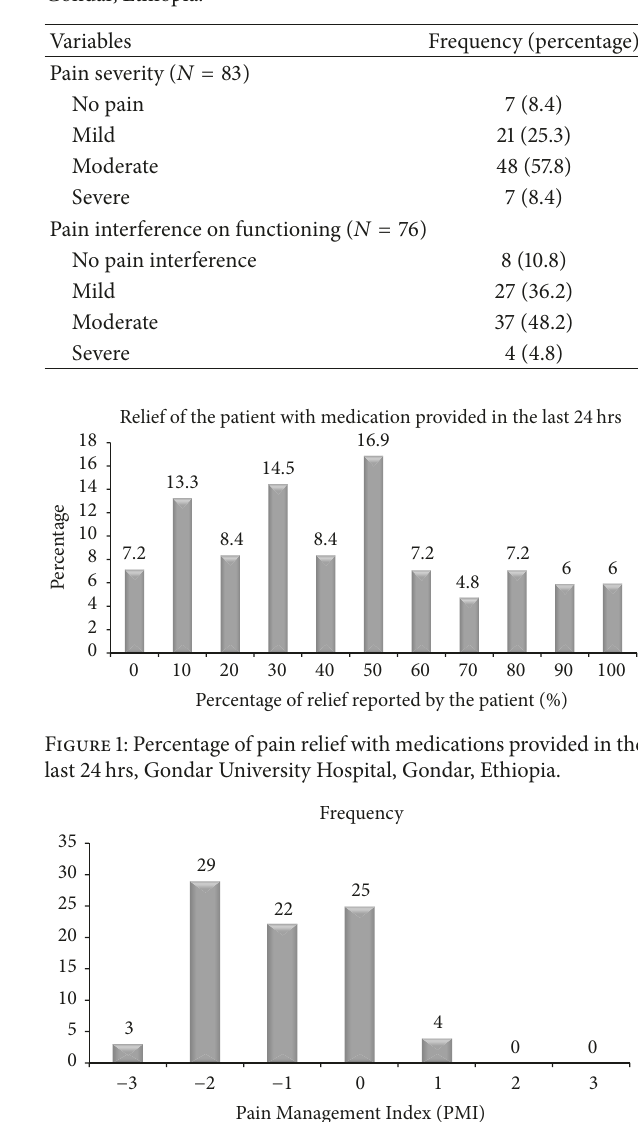
Table 2: Frequency of pain severity and pain interference on functioning among cancer patients at Gondar, University Hospital, Gondar, Ethiopia.